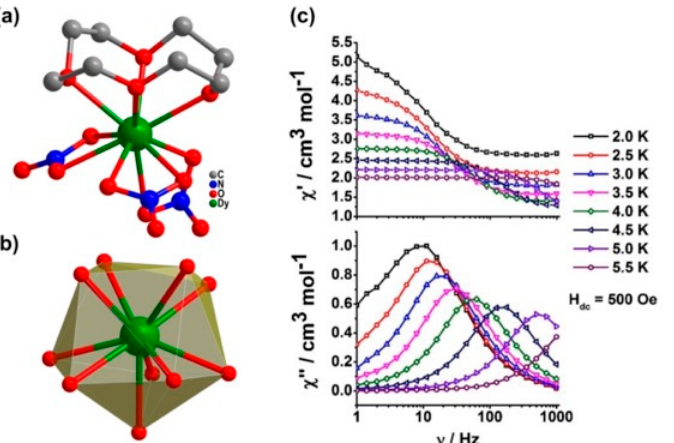
Figure 9. ( a ) Molecular structure of 10 , ( b ) sphenocona coordination geometry around the central Dy(III) ion, and ( c ) frequency-dependent in-phase ( χ ’) and out-of-phase ( χ ”) AC susceptibilities from 2.0 to 5.5 K for 10 under H DC = 500 Oe. Figures and captions are reproduced from Reference [42] with permission from the Royal Society of Chemistry.